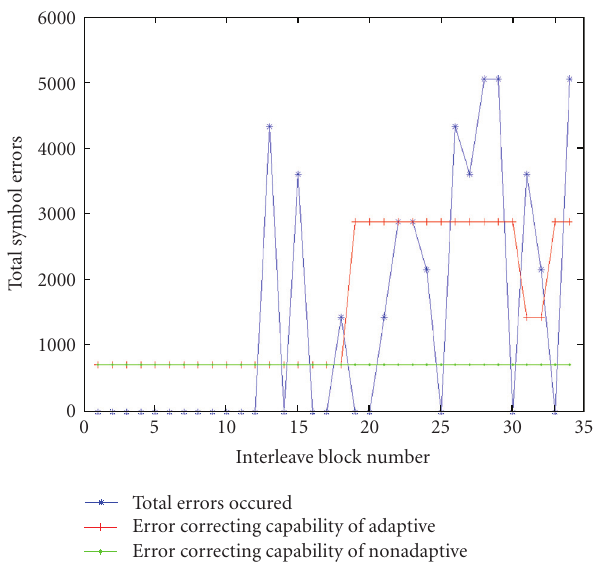
Figure 4: Performance of feedback for “ foreman” sequence at 64kbps, random delay 0.057, bu ff er Size 40, packet size 720, span 20, PL rate